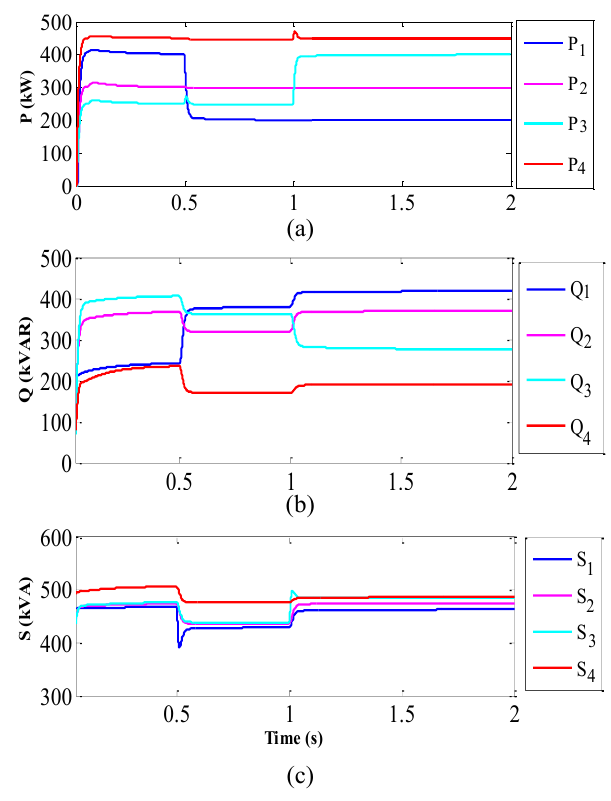
Fig. 7. Results with Proposed algorithm: (a) active power fed by DGs, (b) reactive power shared by the inverters, (c) apparent power of each